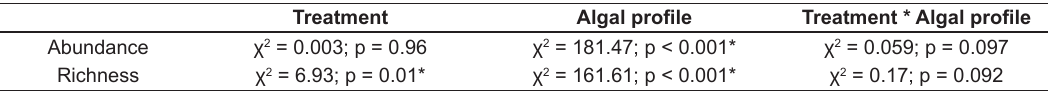
Table 2. Results from generalized linear mixed model fit with binomial negative estimation of the abundance of periphytic algal profiles (low, medium and high) from the food content of Moenkhausia sanctaefilomenae between treatments T1 (without zooplankton) and T2 (with zooplankton). The intercept represents the levels “Treatment-T1” and “High-profile”. SD- standard deviation. SE- standard error. Z- test parameter. P- probability. Residual SD- residual standard deviation.